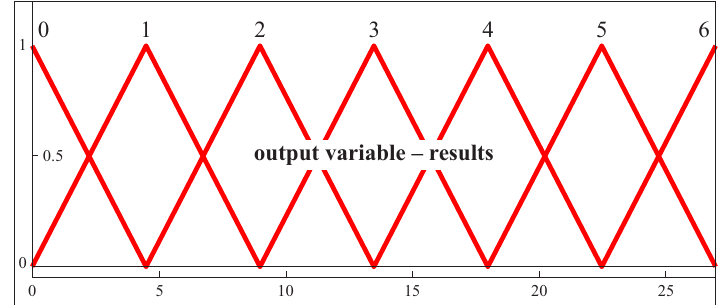
Figure 7. The membership functions for the output parameter in the case of the first free-form surface. The system of the selection of scanning lines from generated cross-sections of a free-form surface is based on the rules, the selected examples of which are presented in Table 1. Table 1. The selected rules for the first part of the developed